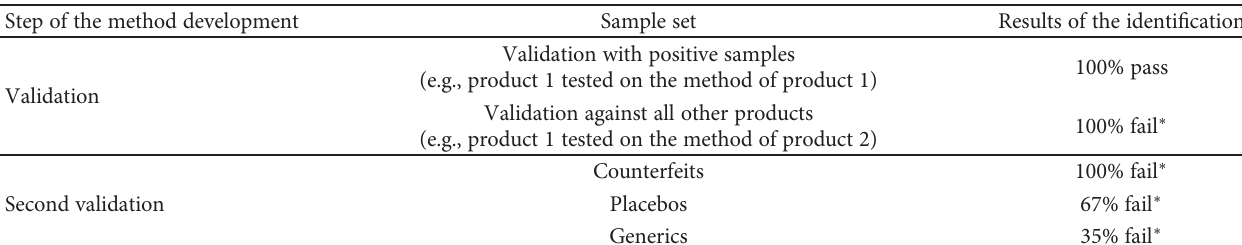
Table 3: Overview of the results obtained for the validation and the tests of the second validation. ( ∗ ) In these tests, “ fail ” is actually the expected answer, since these products should not be identi fi ed by the